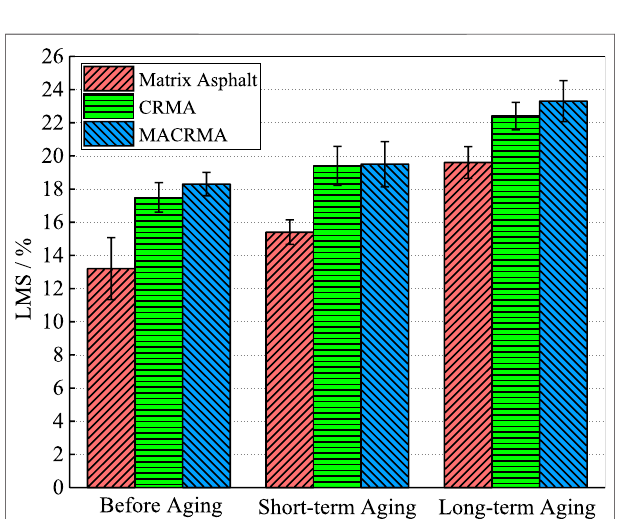
FIGURE 7 | The LMS values from GPC